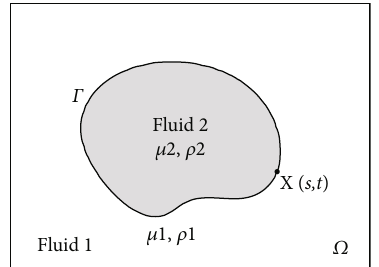
Figure 1: Front-tracking and Immersed boundary curve Γ on a rectangular domain Ω .